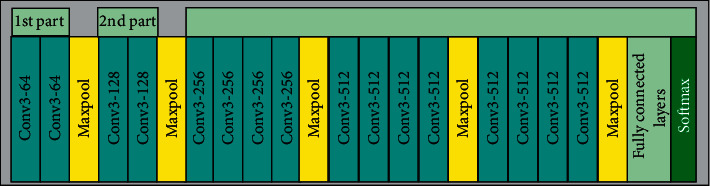
Structure of VGG19.